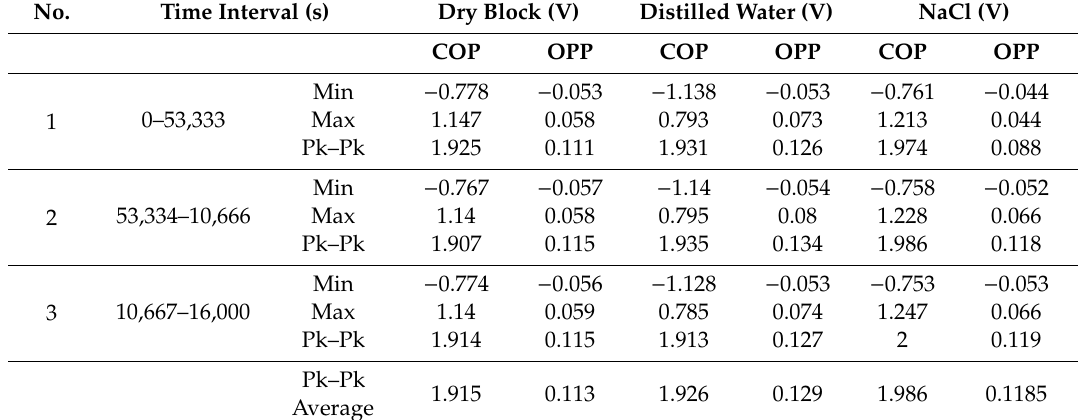
Table 1. Maximum and minimum values of voltage (V) signals obtained for / from three concrete blocks with sensors placed coplanarly (COP) and on opposite surface (OPP).